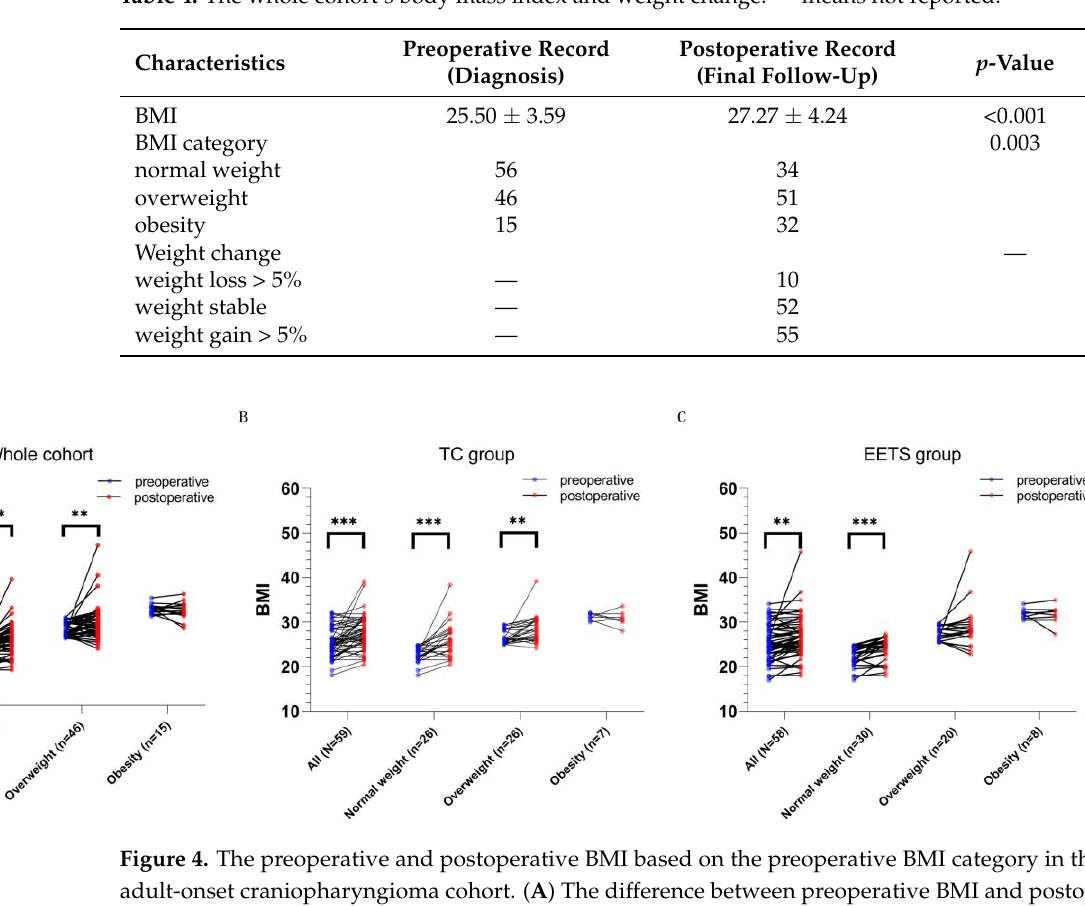
Table 4. The whole cohort’s body mass index and weight change. — means not reported.